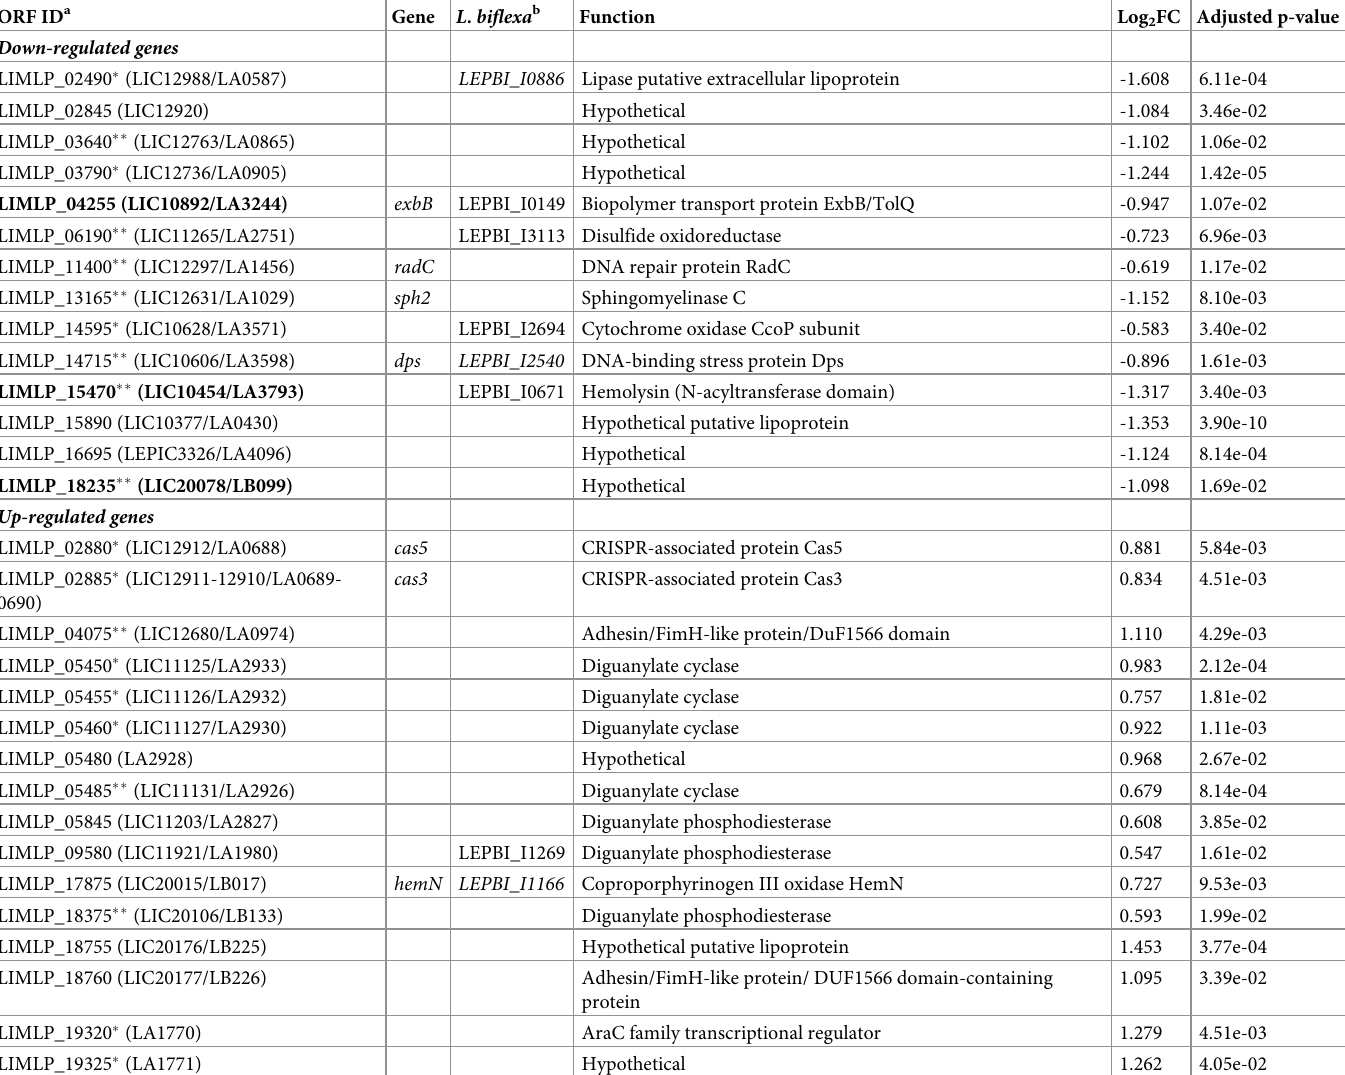
Table 1. Differentially-expressed ORFs upon perRB inactivation.